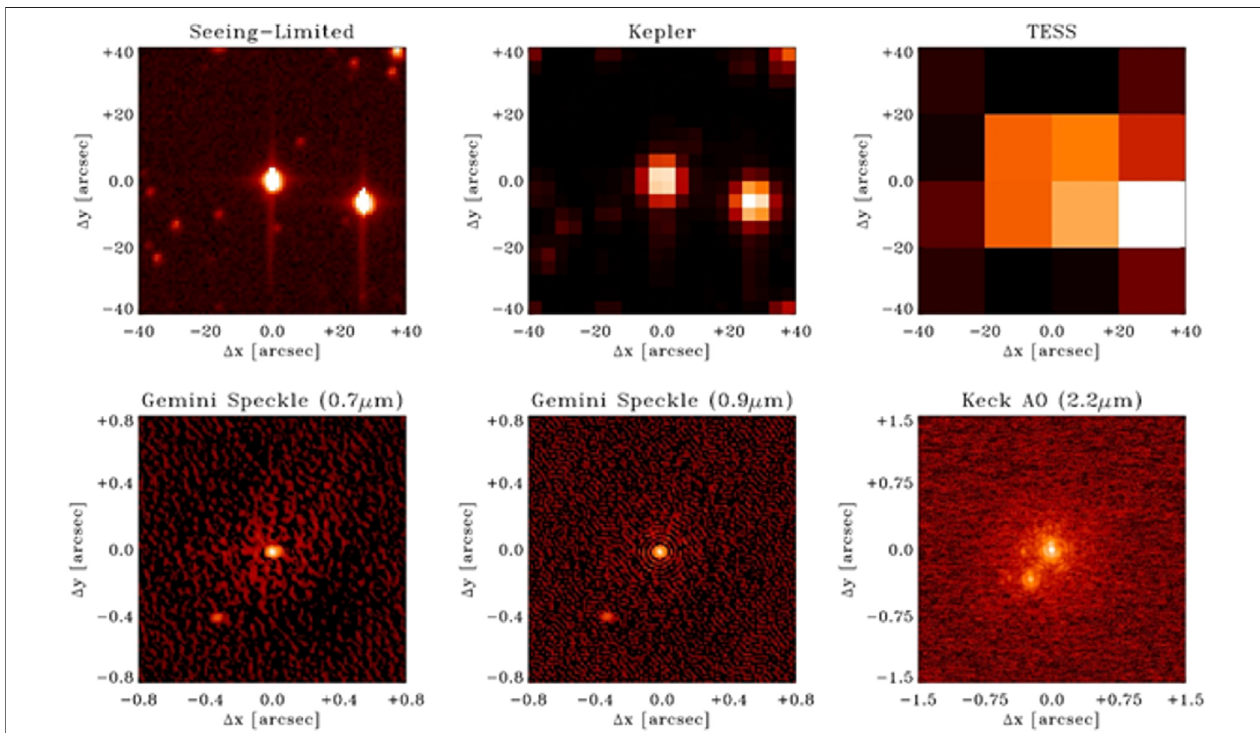
FIGURE 3 | (Top row) Ground-based seeing-limited image of KOI-1002 (star at center) obtained from the Palomar Observatory Sky Survey (POSS). The image showsthelocalstar fi eldwhichcontainstwobrightstars.TheKepler imageisfromthestandard30-minutepostage stampimagesdownloaded fromthespacecraftand the TESS “ image ” was produced (before TESS had observed the Kepler FOV) by convolving the Kepler image with the TESS 20 arcsec pixel size kernel. (Bottom row) Herethemuch smallerspatialdimensionboxesarecenteredonthebrightcentralstarinthetoprowanditisrevealedinthehigh-resolutionimagesthatthestarisa binarysystemwithaseparationofabout0.5 arcsec.TheKeckAOimageshowsthecentral3 arcsecbox.Thespeckleimagestookatotaltimeof5 min(3 minonsource) and reached a contrast of 6.5 magnitudes while the IR/AO image required 15 min total time ( ∼ 1.5 min on source) and reached a contrast limit of 9.2 magnitudes. The inner working angle for the speckle and IR/AO observations was ∼ 20 and ∼ 80 mas